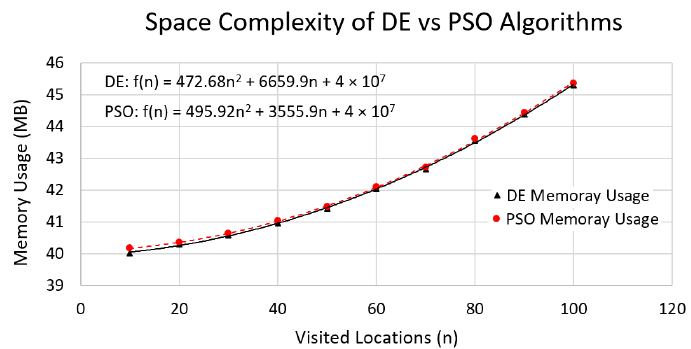
Figure 9. Plot between the algorithm runtimes (DE and PSO) and the visited locations. The quadratic regression fits and their functions are included.